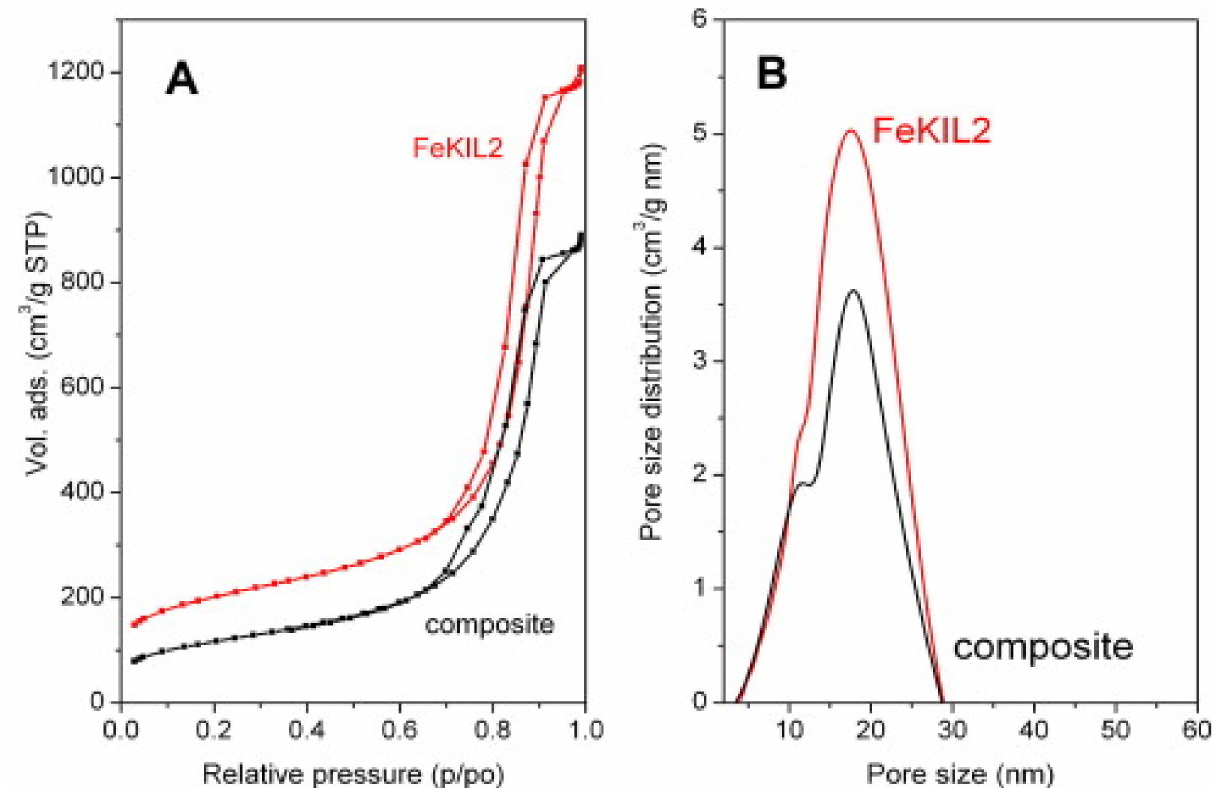
Figure 9. ( A ) Nitrogen sorption isotherms and ( B ) pore size distributions of the mesoporous FeKIL2 and the composite CaCl 2 -FeKIL2. (Reprinted from [150], copyright (2012), with permission from